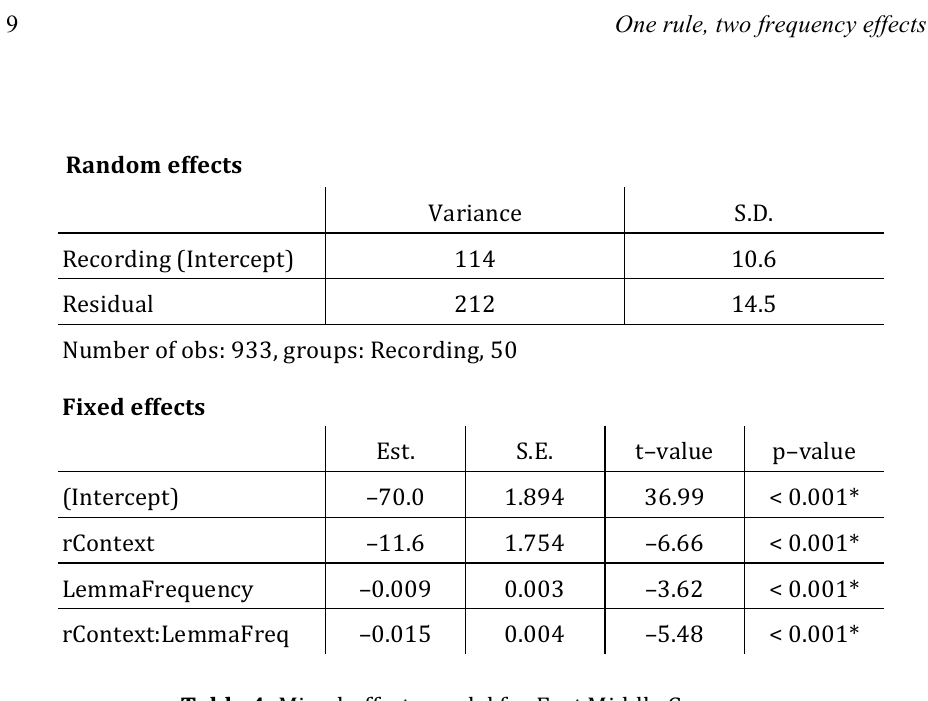
Table 4: Mixed-effects model for East Middle German